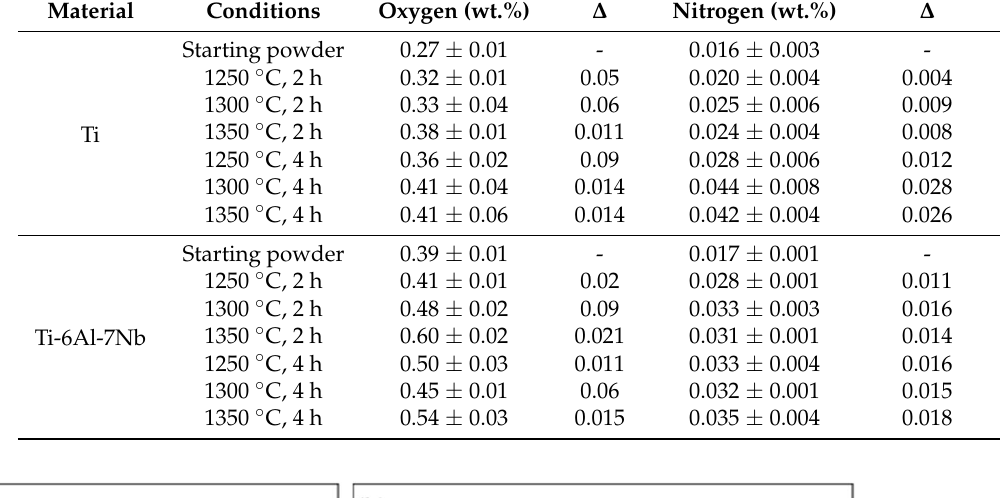
6 Table 1. Chemical analysis of the P/M Ti and Ti-6Al-7Nb alloy sintered using different combinations of sintering temperatures and dwell times.